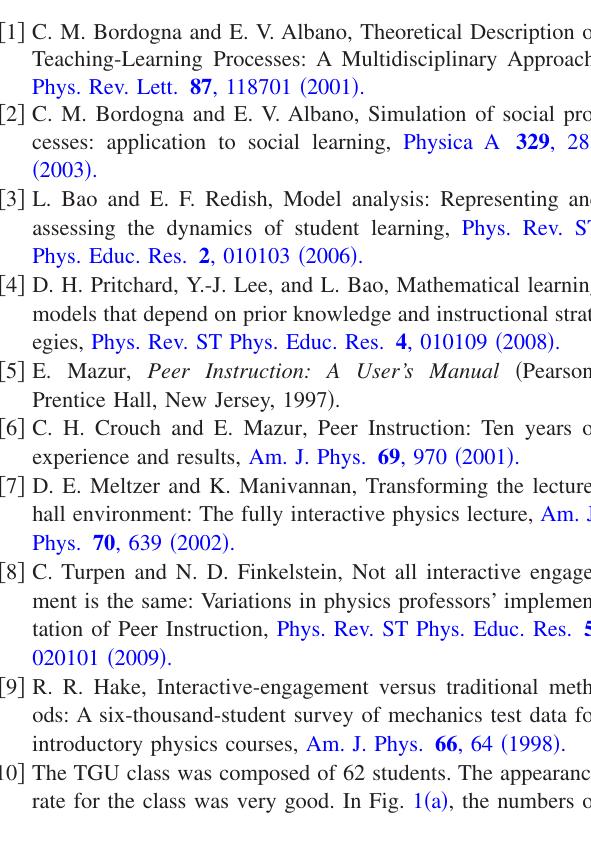
polling students are 55 for two points, 58 for one point, and more than 60 students for the rest of 20 points. The TGU high-school data are given as the sum of three classes for each year. A class is composed of about 45 students. All classes were given essentially the same lectures. The PI data in the Fig. 1 (cid:1) b (cid:2) are the sum of 110 to 127 responses of students. The fluctuation of the responses is due to the different number of appearance to the class and of imperfect responses: responses only before or after PI have not been included in our data. (cid:3) 11 (cid:4) E. F. Redish, Teaching Physics with the Physics Suite (cid:1) Wiley, New York, 2003 (cid:2) . (cid:3) 12 (cid:4) In Japan an academic year starts from April. Usually, a lecture of 90 min. is given weekly. A semester course is composed of 15 lectures. (cid:3) 13 (cid:4) M. Kaneta and H. Nitta, Practice of peer instruction by use of